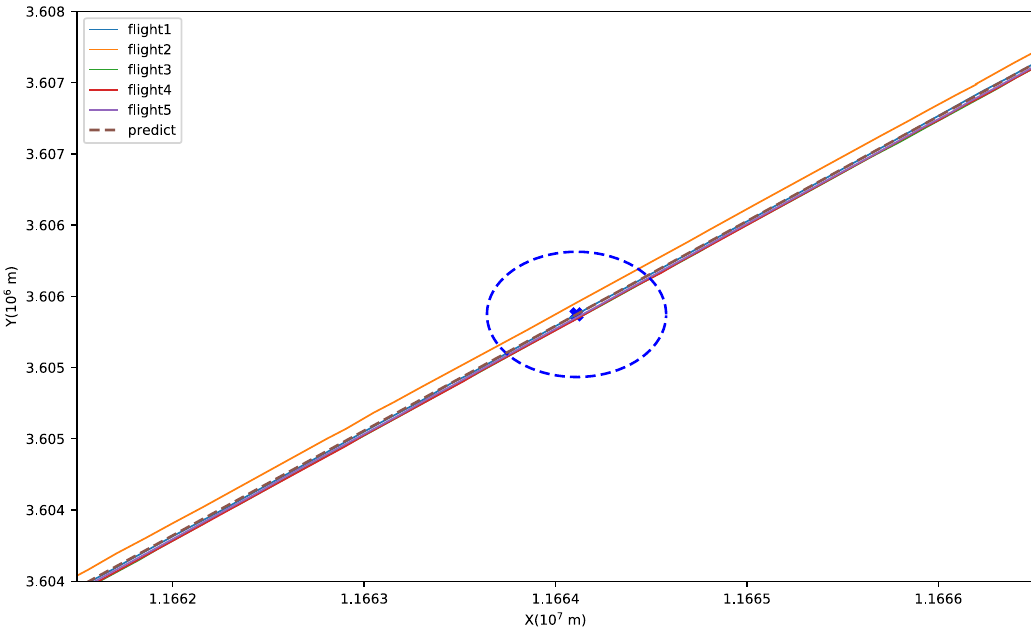
Figure 7. Predicted trajectory and its probabilistic distribution for a cruise flight.